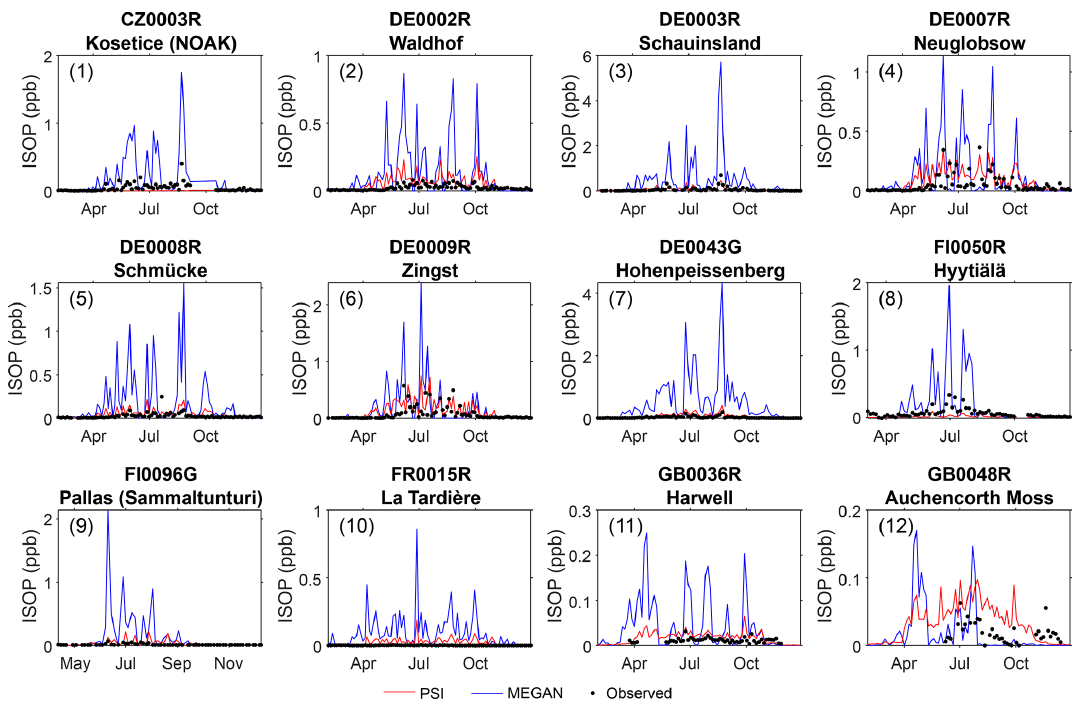
Figure 4. Comparison between modelled and measured isoprene concentrations in 2011. The measurement data were obtained from the EBAS database (http://ebas.nilu.no/, last access: 12 March 2019) operated by Norwegian Institute for Air Research (NILU). The time resolution of measurements varies with sites: at station 9 FI0096G every 72h, at stations 1–6 and 10 every 96h, and at stations 7, 8, 11, and 12 every 3–12h but averaged to 96h for better visualisation. Table 2. Comparison between modelled and measured mean afternoon (12:00–18:00UTC) mixing ratios of surface ozone at 537 rural AirBase stations. NE represents northern Europe, CE central Europe, and SE southern Europe. MB: mean bias; ME: mean error;